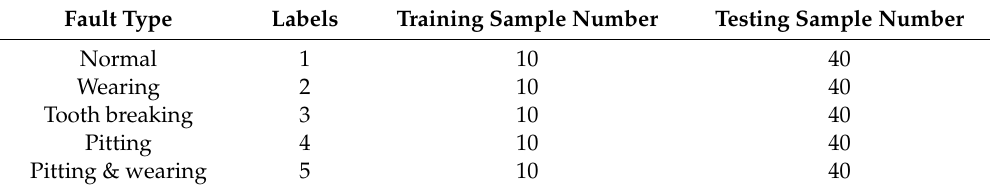
Figure 13. The experimental platform of the gearbox from QPZZ-II. Table 14. Experimental sample description of the gearbox.